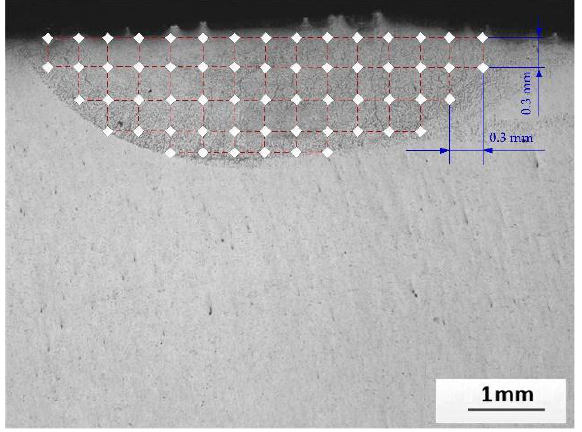
Figure 11. Schematic diagram of the microhardness test.